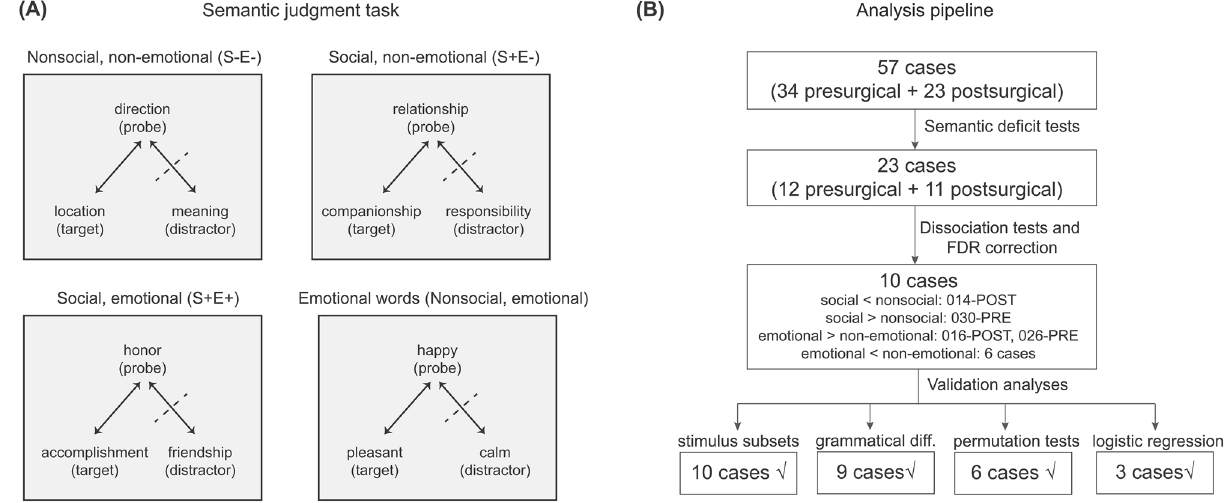
Figure 1. Semantic judgment task ( A ) and scheme of analysis pipeline ( B ) in this